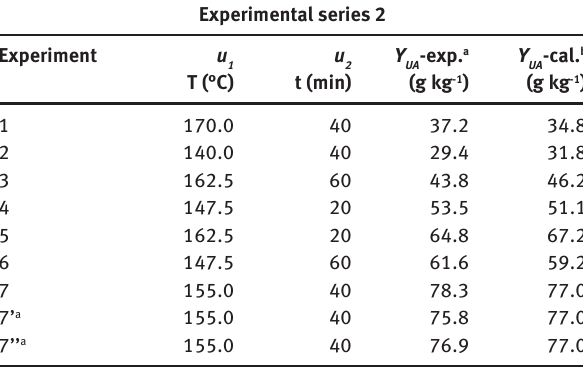
Table 3: Doehlert experimental design with significant ( u ables and values of corresponding experimental and calculated responses ( Y in WS fractions) for hydrothermolysis of high methyl UA ester citrus-apple